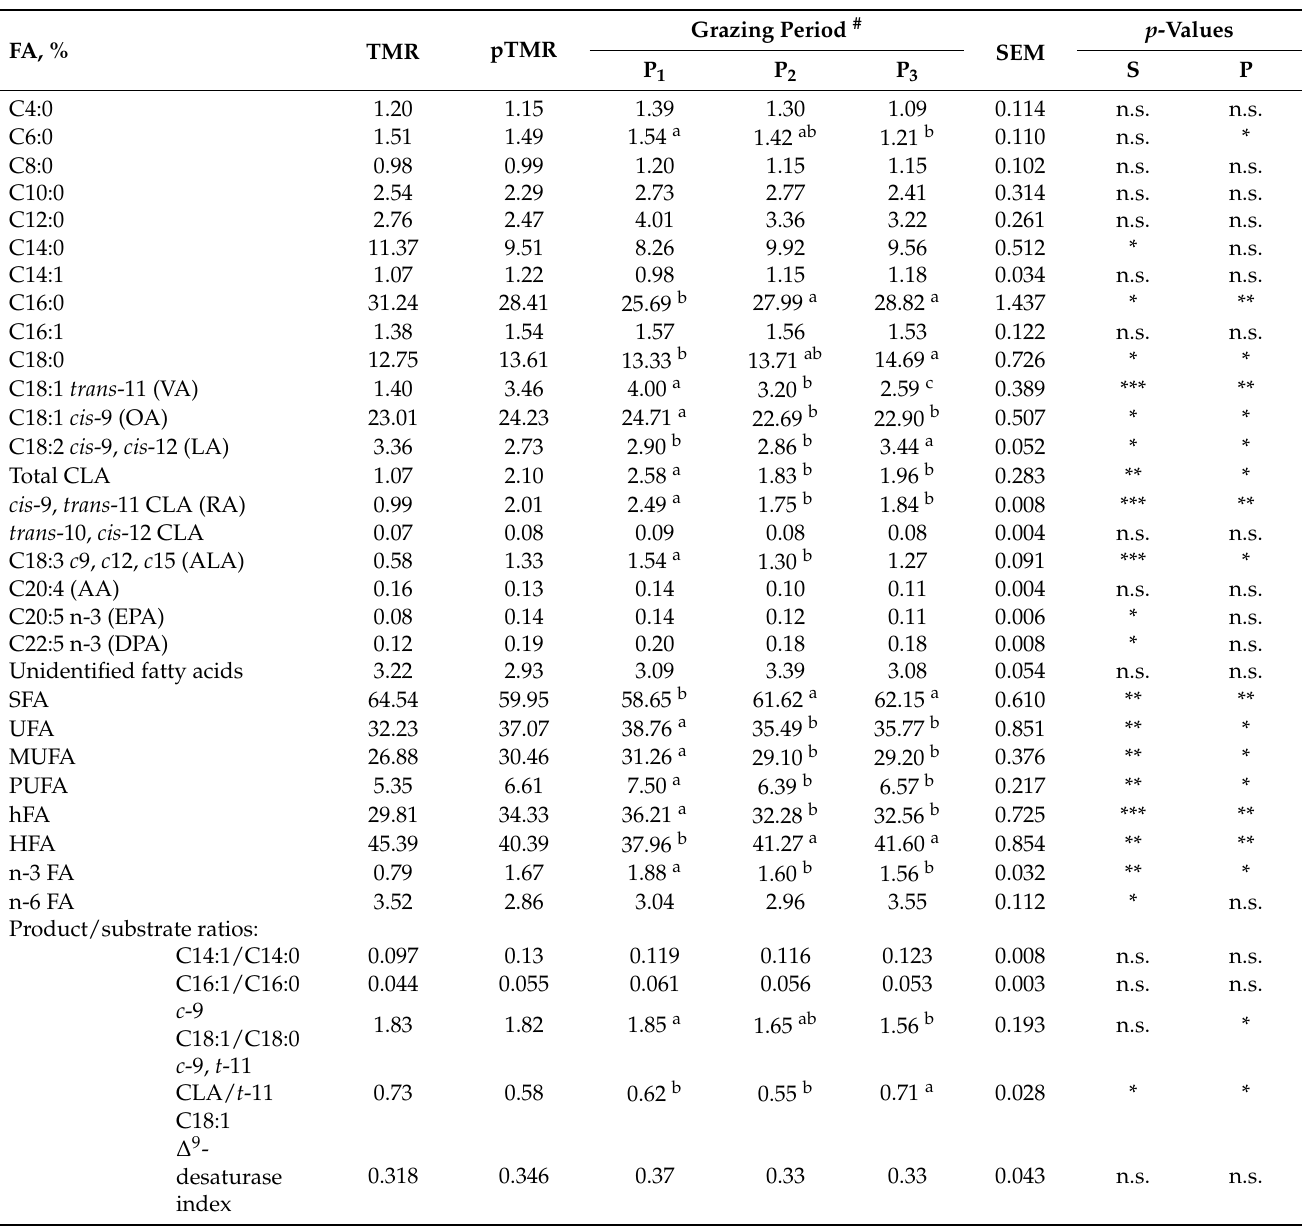
Table 4. Effect of cow feeding system (S: TMR vs. pTMR) and grazing period (P) on milk fatty acid (FA)